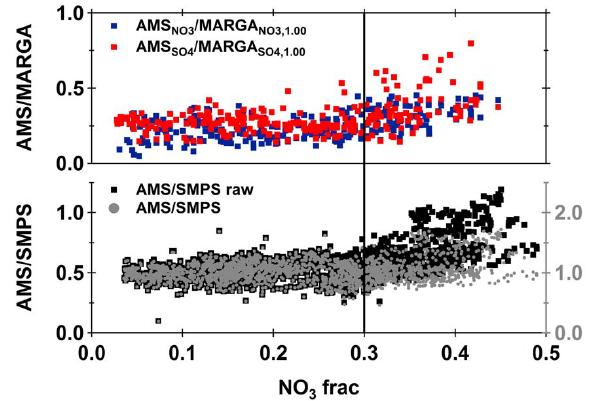
Fig. 3. Lower panel: ratio of raw (black squares, left axis) and CE Figure 3: Lower panel: Ratio of raw (black squares, left axis) and CE corrected (grey dots, 3 corrected (grey dots, right axis) AMS total mass to SMPS derived right axis) AMS total mass to SMPS derived aerosol particle mass as function of nitrate mass 4 aerosol particle mass as a function of nitrate mass fraction (MF NO fraction ( MF NO3 ) in the particles. Top panel: Raw AMS/MARGA-Sizer (1.00 µm) nitrate 5 in the particles. Top panel: raw AMS/MARGA-Sizer (1.00µm) ni- (blue) and sulfate (red) mass ratios. Note that the CE of the AMS shows a dependence on the 6 trate (blue) and sulfate (red) mass ratios. Note that the CE of the aerosol nitrate fraction with increasing nitrate fraction leading to increasing collection 7 AMS shows a dependence on the aerosol nitrate fraction with in- efficiency. 8 creasing nitrate fraction leading to increasing collection